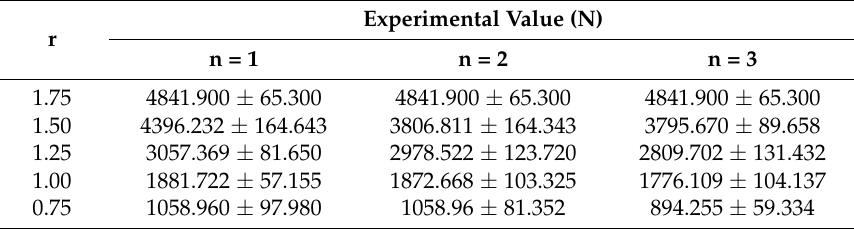
Table 3. Experimental values of the structural load capacity.